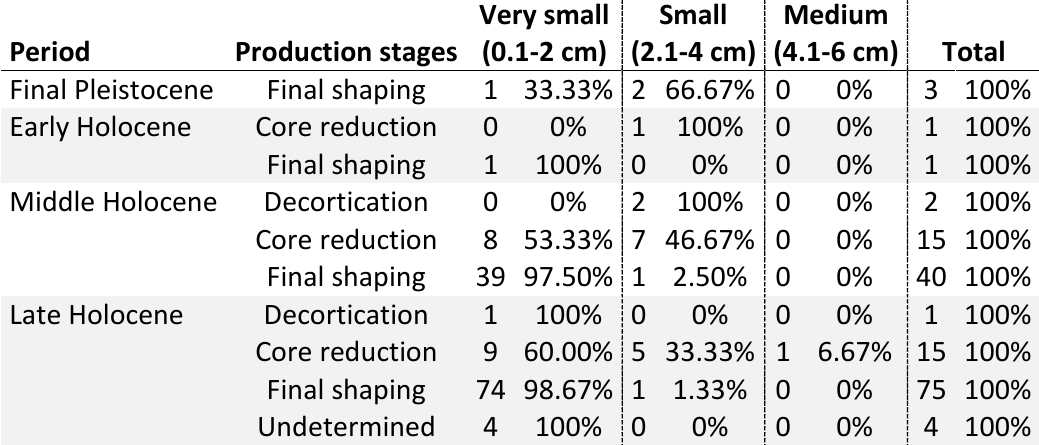
Table 8. Size of complete flakes for each production stage and occupation